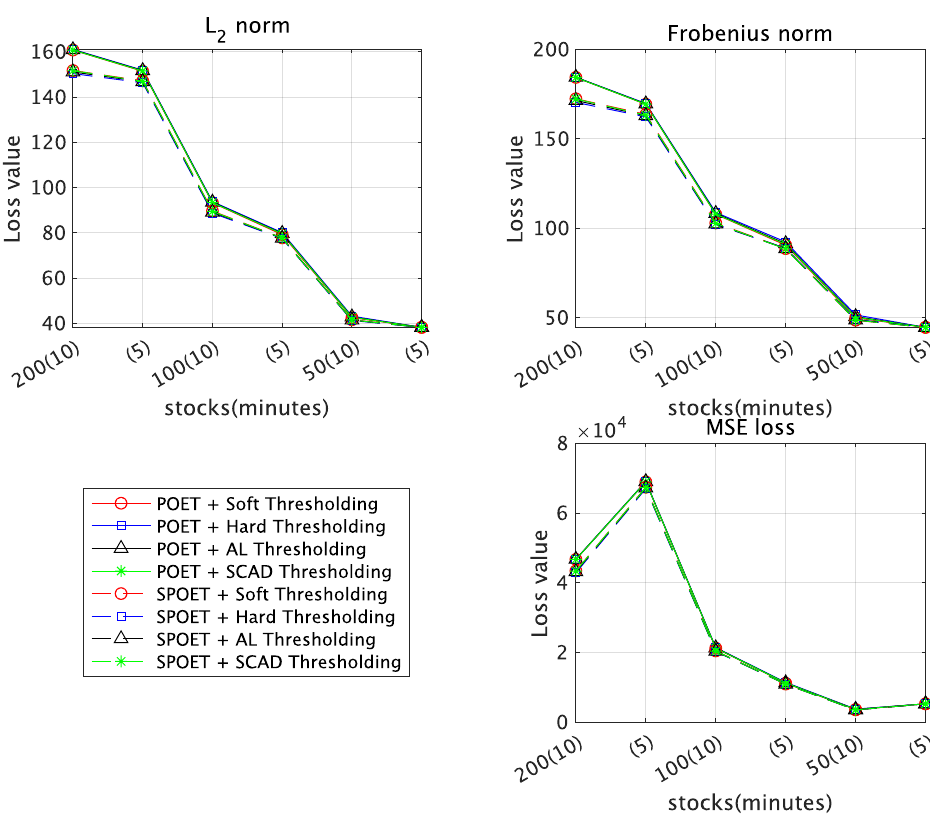
Figure 1. Simulation results. Notes: the x axis shows the number of stocks and the time interval of realized covariance